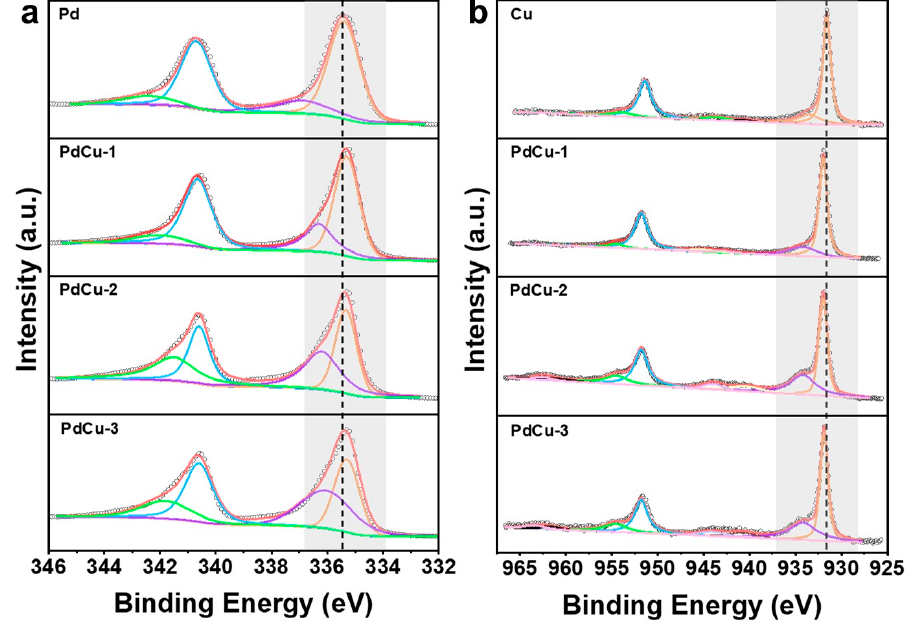
Figure 2. XPS spectrum of Pd, PdCu − 1, PdCu − 2, PdCu − 3, and Cu: ( a ) high-resolution XPS spectrum of Pd 3d for Pd, PdCu − 1, PdCu − 2, and PdCu − 3; ( b ) high-resolution XPS spectrum of Cu 2p for Cu, PdCu − 1, PdCu − 2, and PdCu − 3.